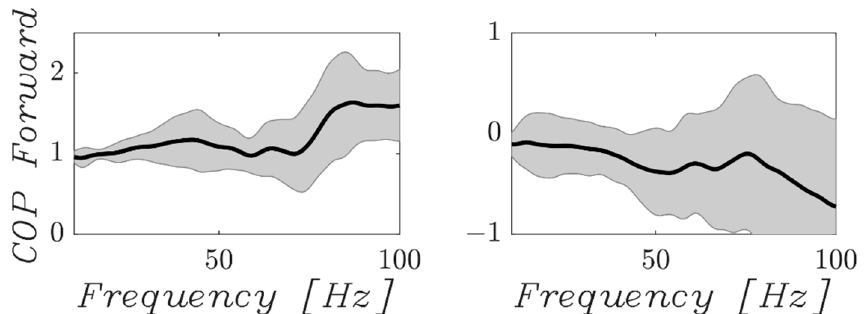
Figure 3. Measured amplitude and phase of the vibration transmissibility of the toes. Transmissibility is reported for all three COP positions (backward, natural and forward). The mean value (solid black line) and variability (grey cloud), representing a 95% confidence interval, were computed among the subjects included in the optimization procedure.